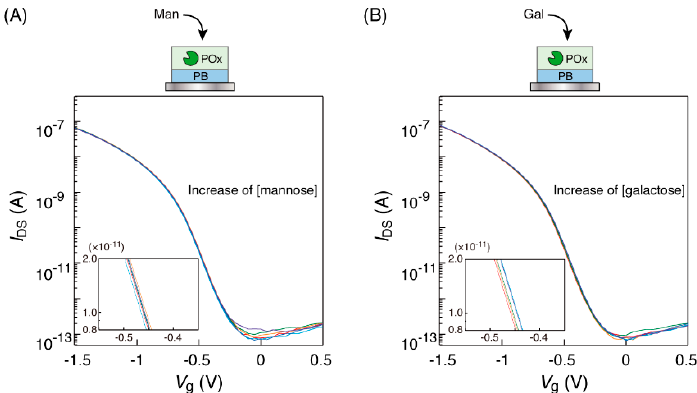
Figure 4. Transfer characteristic curves of the organic field-effect transistor (OFET) biosensor with a POx-PB electrode obtained in response to the electrode’s immersion into ( A ) mannose and ( B ) galactose solutions at different concentrations (0, 0.1, 0.5, 1, 3 and 10 mM), buffered by 1×PBS at 25 °C. Each concentration curve has been indicated in red (0 mM), orange (0.1 mM), green (0.5 mM), light blue (1 mM), blue (3 mM) and purple (10 mM), respectively. The insets show the enlarged views.